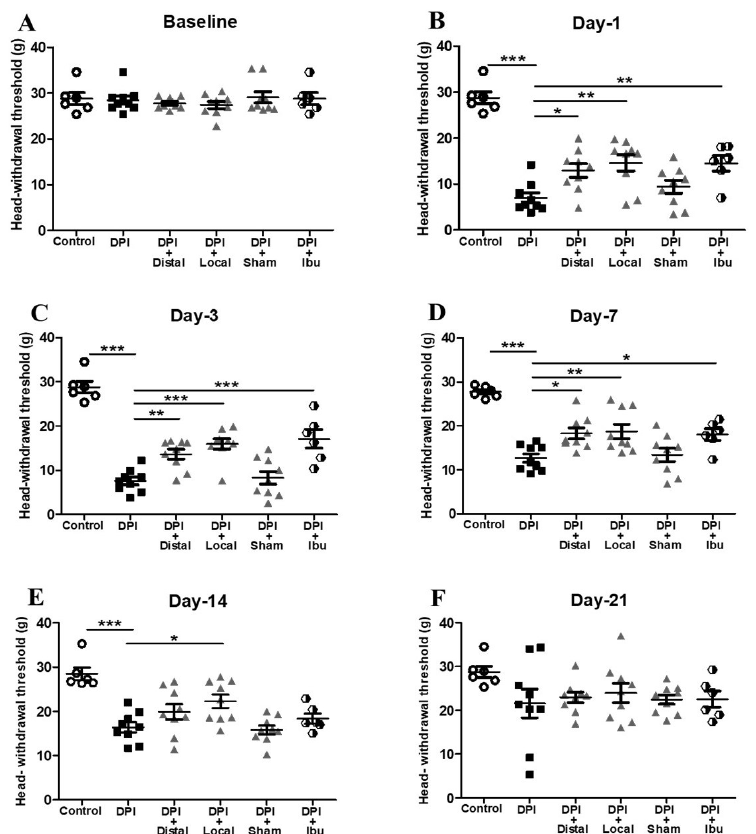
Figure 1. Verum (local and distal) electroacupuncture (EA) and ibuprofen alleviated mechanical allodynia following dental pulp injury (DPI). ( A ) Baseline measurements. ( B ) On day 1, mice in the DPI group exhibited a robust sign of mechanical allodynia when compared with controls. These effects were significantly attenuated by verum (local and distal) EA, as well as by ibuprofen. ( C ) On day 3, verum (local and distal) EA, along with ibuprofen, demonstrated good analgesic effects compared with the DPI group. ( D ) On day 7, the local EA was associated with a higher nociceptive threshold than either distal EA or ibuprofen. ( E ) On day 14, only local EA significantly showed analgesic effectiveness ( F ) On day 21, there was no difference in pain-related behaviors among all studied groups. Sham EA failed to demonstrate any significant effects upon mechanical allodynia on any of the testing days. Between-group comparisons for each group were performed by ANOVA, followed by Dunnett’s test (* p < 0.05, ** p < 0.01, *** p < 0.001, versus DPI group; n = 9 in each